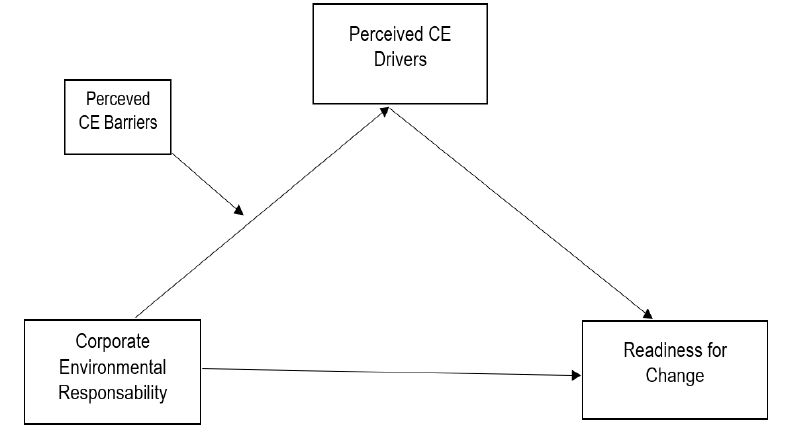
Figure 1. The moderated mediation model.